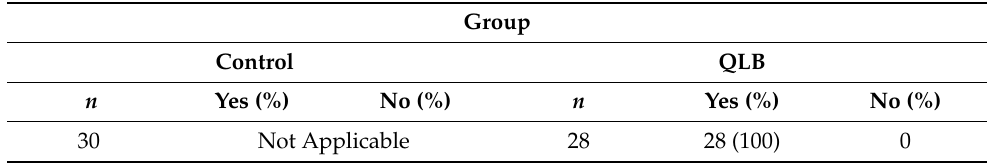
Table 5. Answer to question no. 6 from the survey. Would you like to have a quadratus lumborum block (QLB) performed again in the future for the treatment of postoperative pain? Group